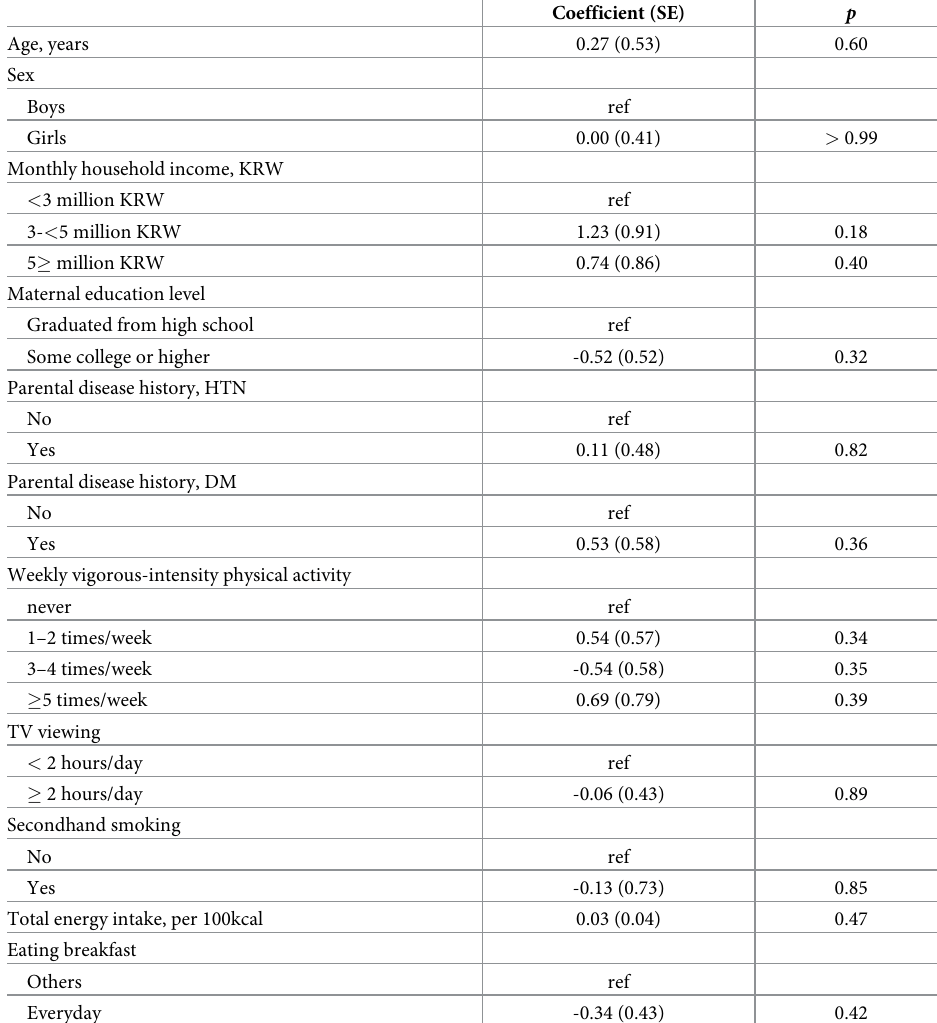
Table 2. Effect of subjects’ characteristics on cMetS